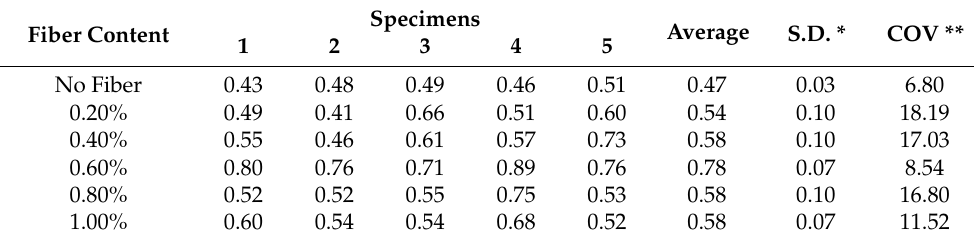
Table 2. First peak strength